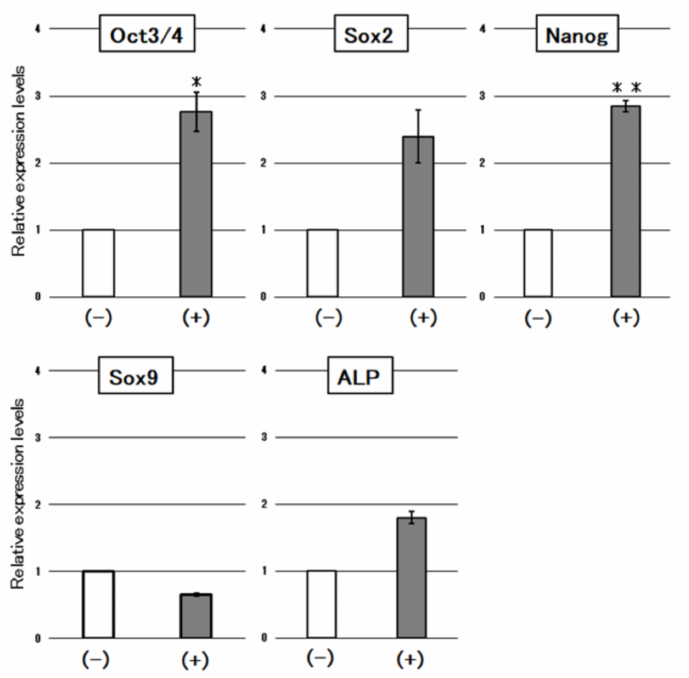
Figure 4. Effect of non-thermal atmospheric pressure plasma (NTAPP) on the expression of pluripo- tency markers ( Oct3/4, Sox2, Nanog, Sox9 , and ALP ) in human deciduous dental pulp fibroblast-like cells (hDDPFs). ( − ) indicates the control group (non-NTAPP treated cells), and (+) indicates NTAPP- treated cells. Values were normalized using GAPDH as the internal control. Data are presented as means ± SE ( n = 5). Data from five different experiments are shown. * and ** indicate significant differences at p < 0.05 and p < 0.01,